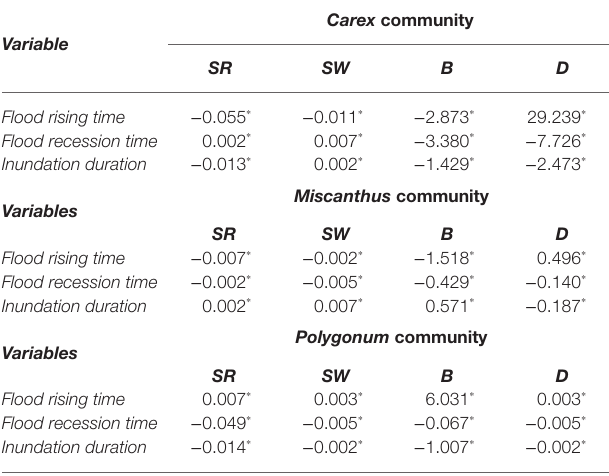
Frontiers in Plant Science | www.frontiersin.org